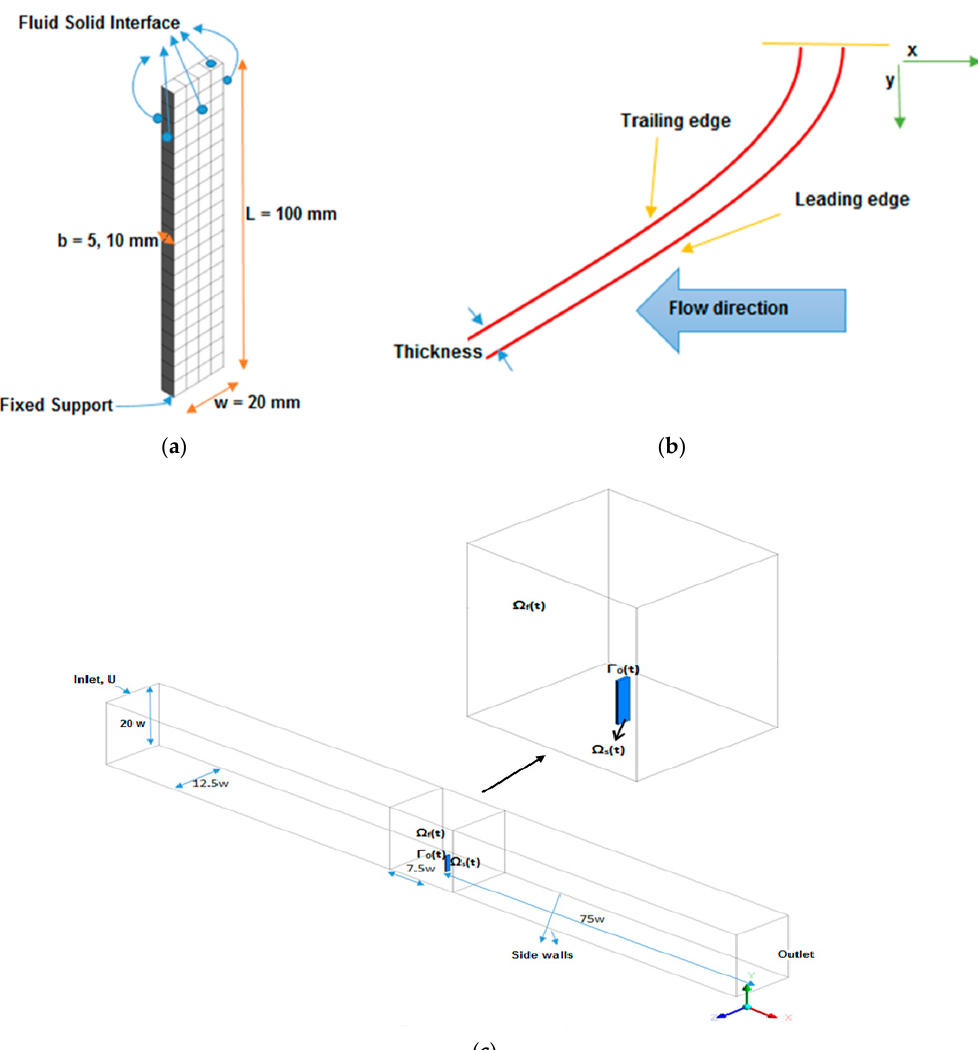
Figure 2. ( a ) Flap configuration; ( b ) Bending definitions; ( c ) Computational domain.